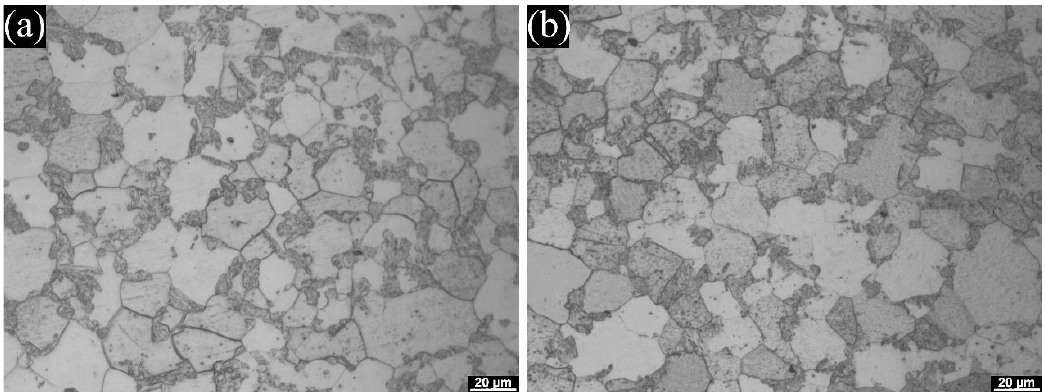
Figure 10. Microstructure of the fine-grain zone in the HAZ: ( a ) without ultrasonic treatment and ( b ) with ultrasonic treatment.